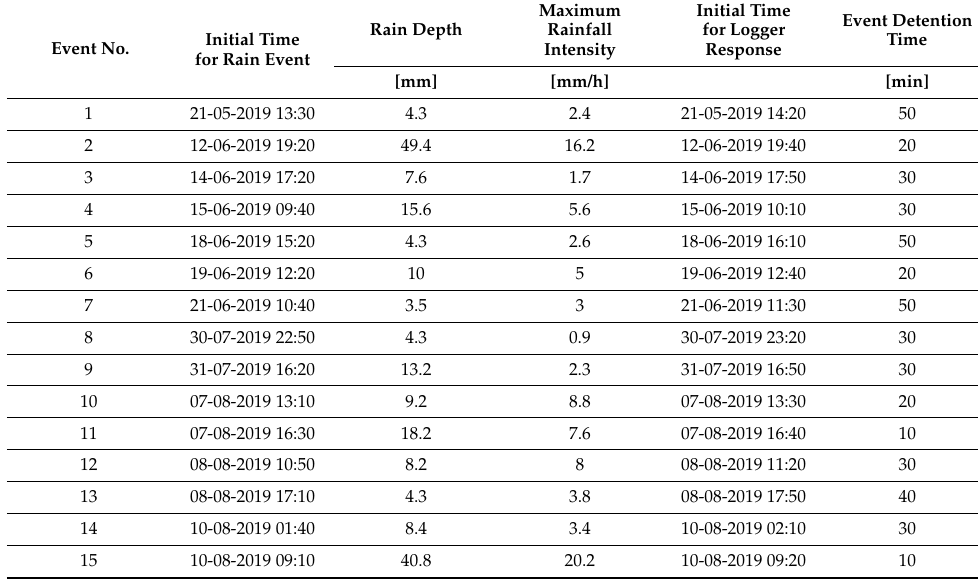
Table 3. Event detention